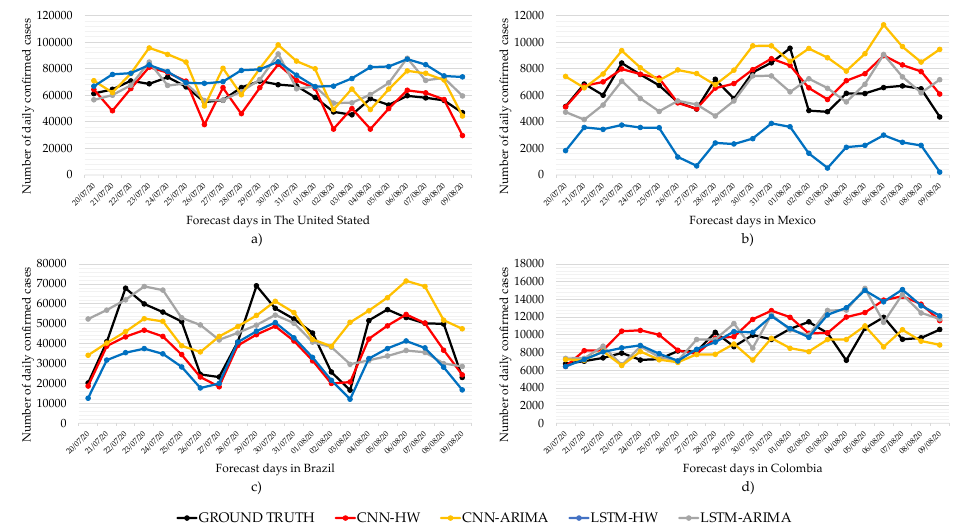
Figure 4. Daily forecast with CNN–CT method using CNN and Long Short-Term Memory (LSTM) as main forecast